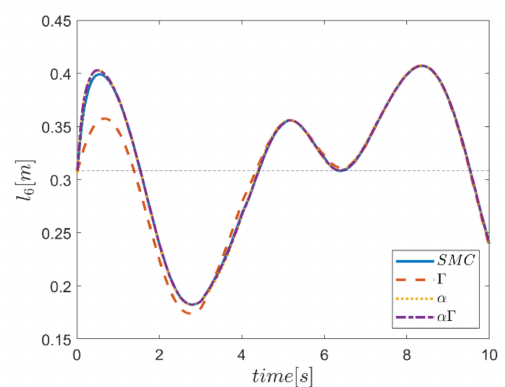
Figure 39. Comparison of the length of the sixth actuator.